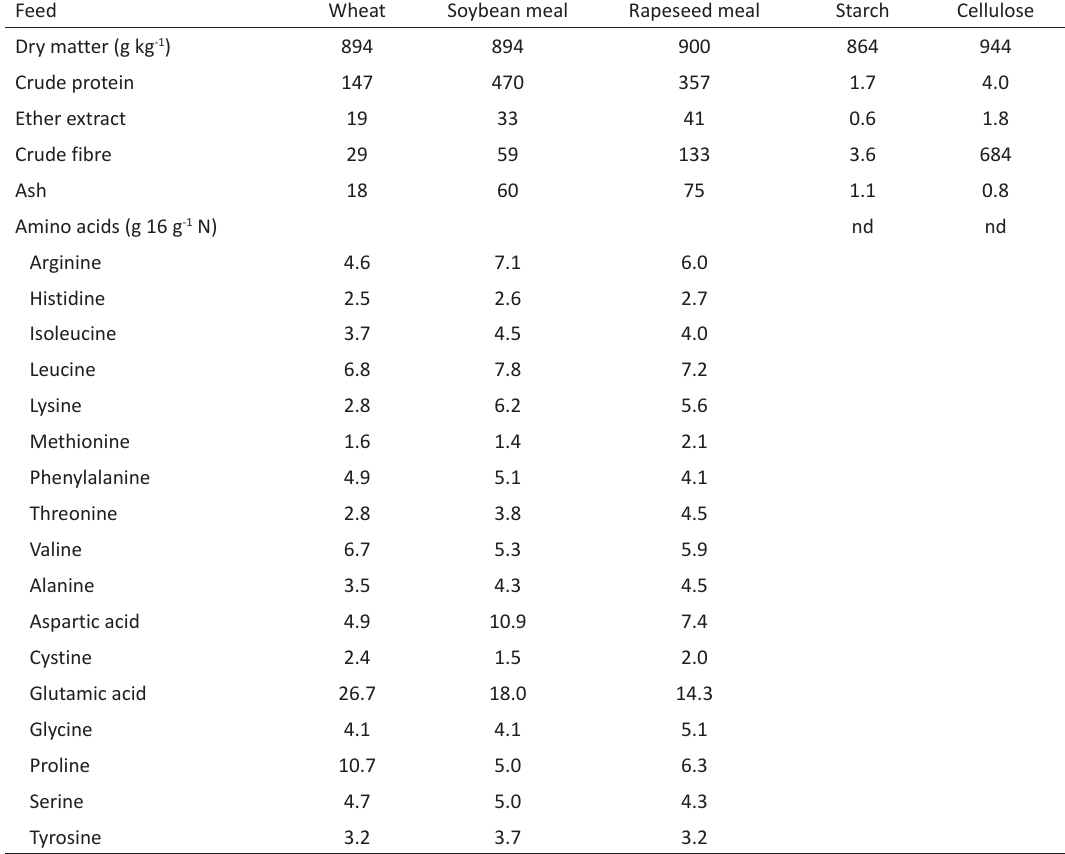
Feed Wheat Soybean meal Rapeseed meal Starch Cellulose Dry matter (g kg -1